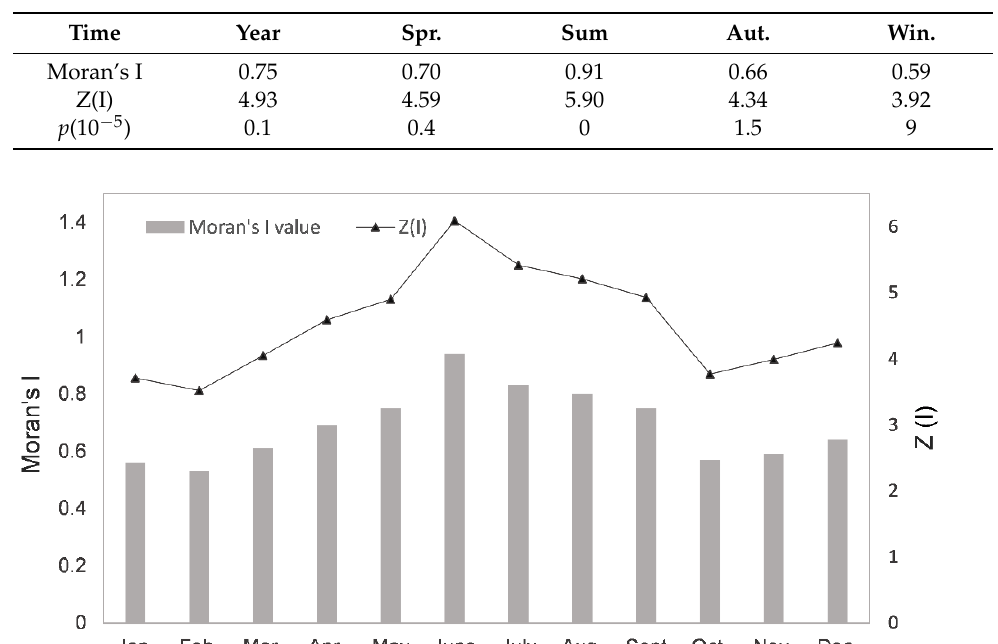
Table 1. Spatial autocorrelation value of ozone five-year/seasonal average concentration in HCUA, 2015–2019.